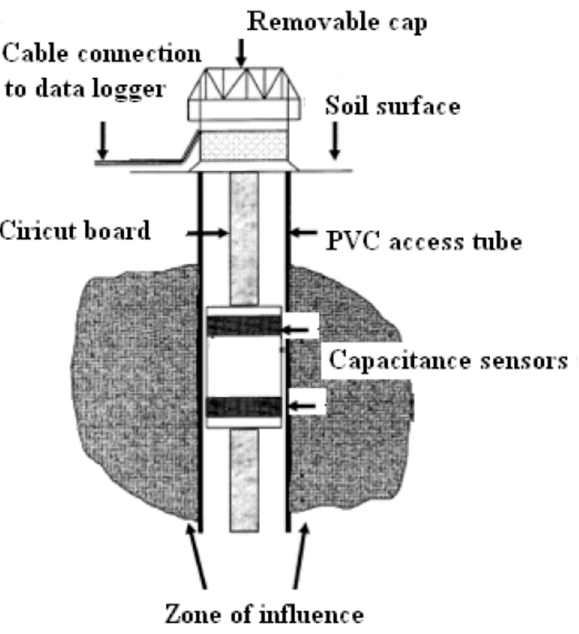
Figure 2. EnviroScan capacitance sensor as installed in a PVC access tube in the field [11].